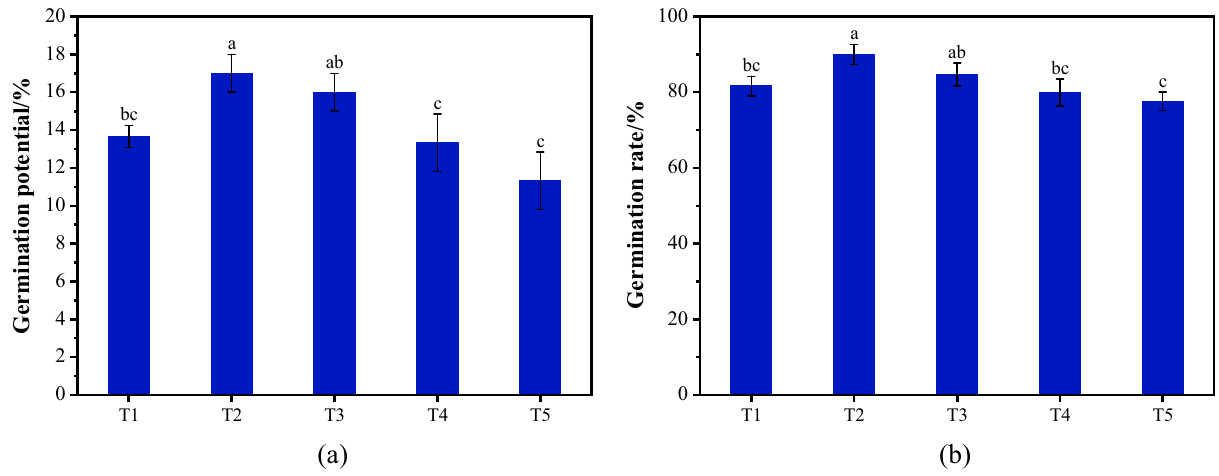
Figure 1. Effects of mine water on seed germination (One-Way ANOVA, α = 0.05). ( a ) Germination potential; ( b ) the germination rate.